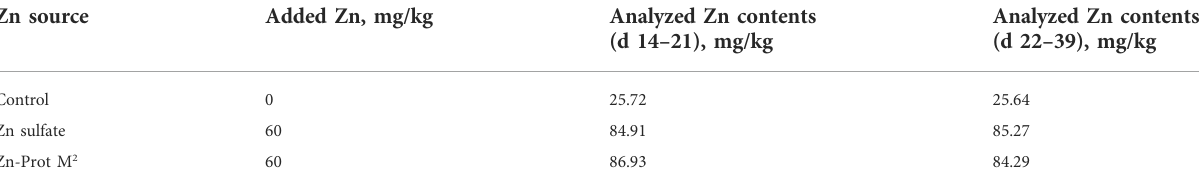
TABLE 2 Analyzed Zn concentrations in diets of broilers from 14 to 39 days of age a . Zn source Added Zn,